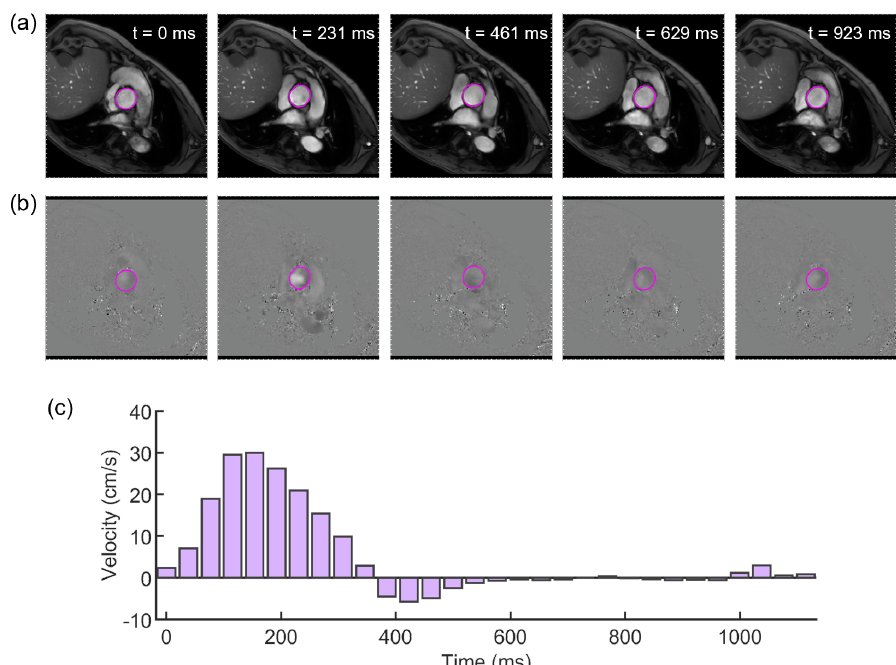
Figure 2. Evenly spaced subsample of PCMRI frames, with aortic lumen countered with ROI (magenta) in both magnitude ( a ) and phase images ( b ); ( c ) flow velocity (magenta boxes) obtained from PCMRI segmentation of the lumen of the